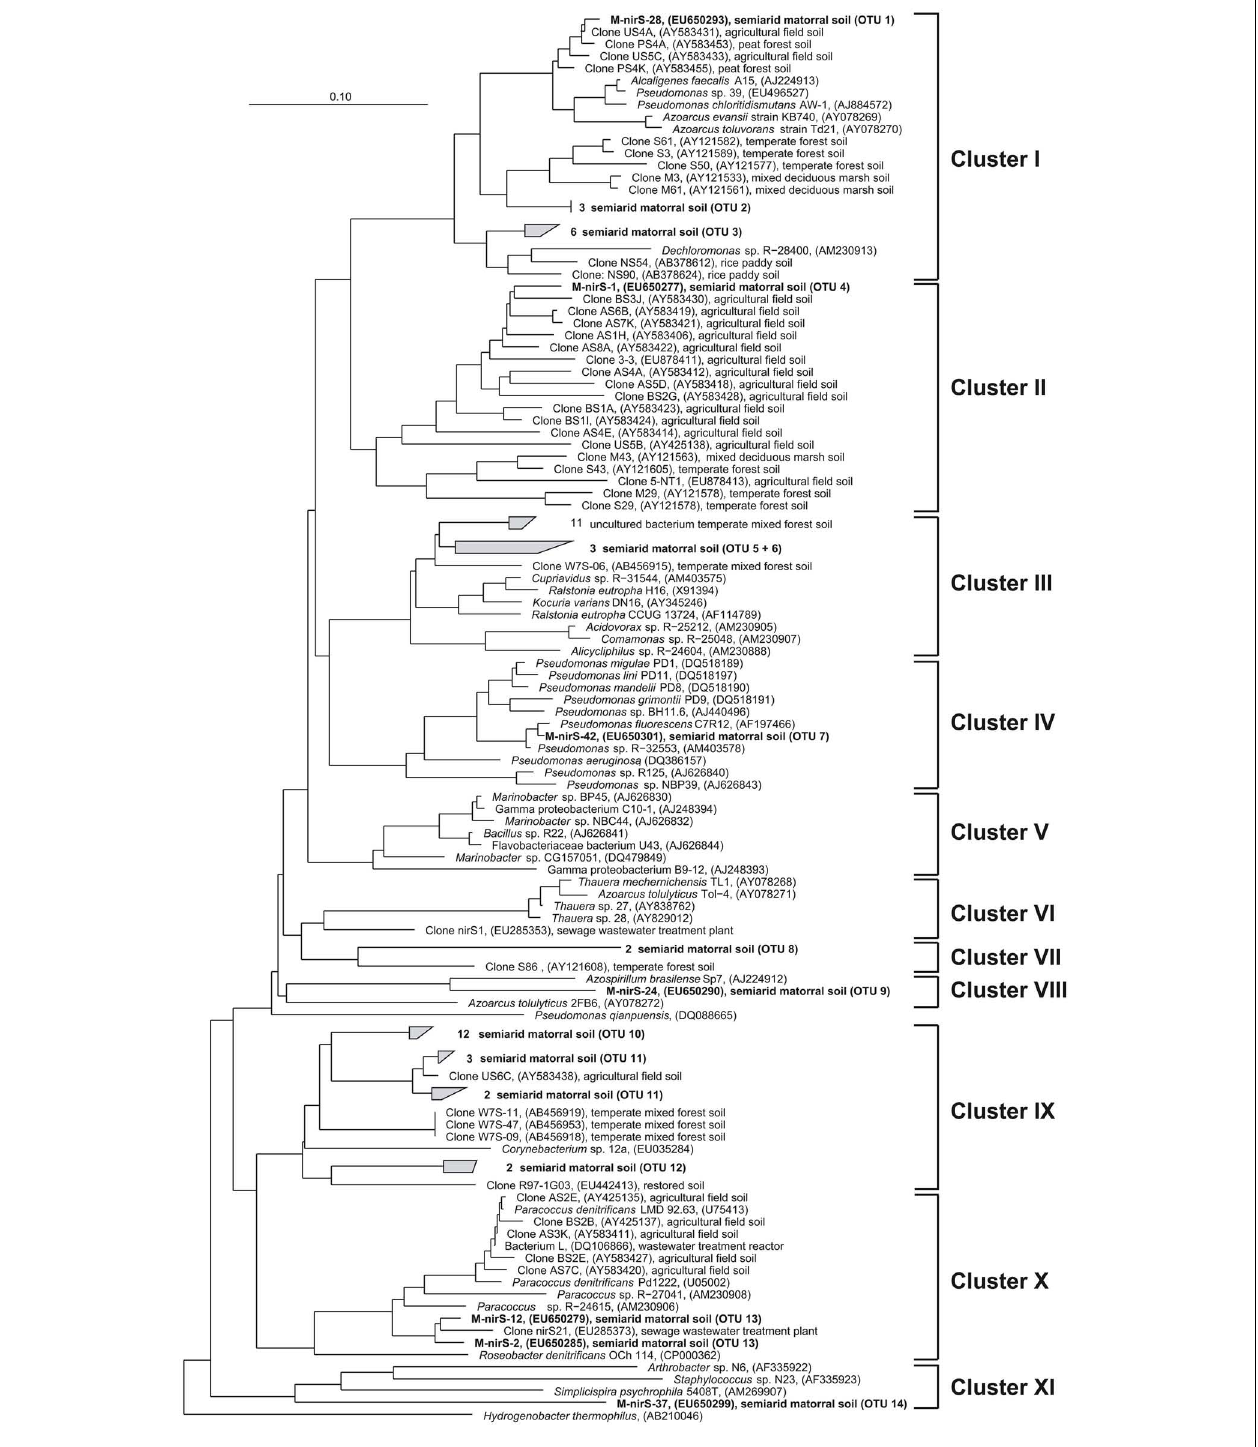
FIGURE 4 | Neighbor joining tree (Kimura amino acid replacement model) based on 131 deduced amino acid positions of nirS gene sequences retrieved from soil samples of the